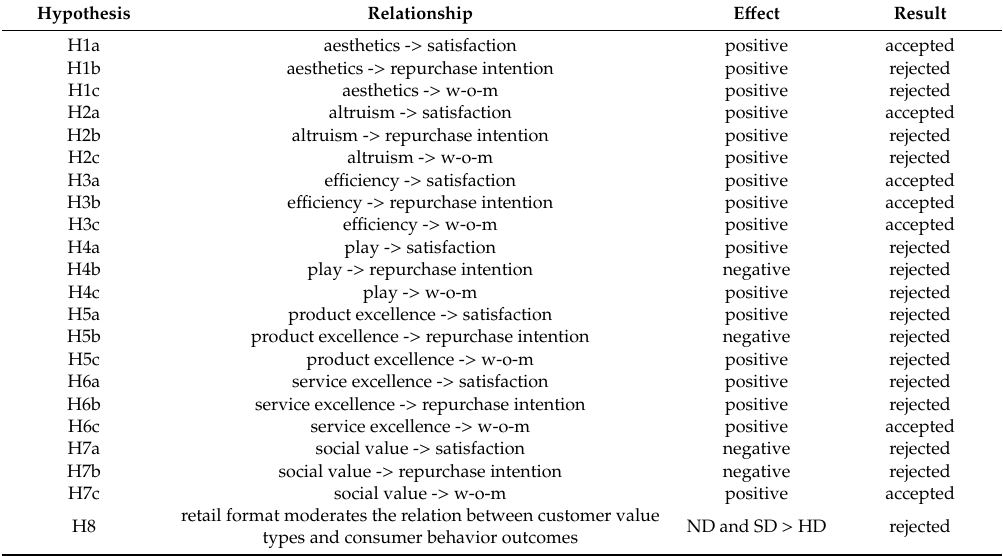
Table 9. Overview of hypotheses